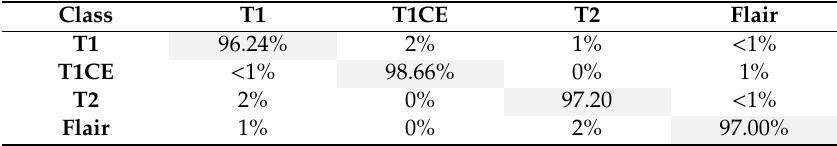
Table 5. Confusion matrix of the proposed method for the BraTS 2017 dataset.